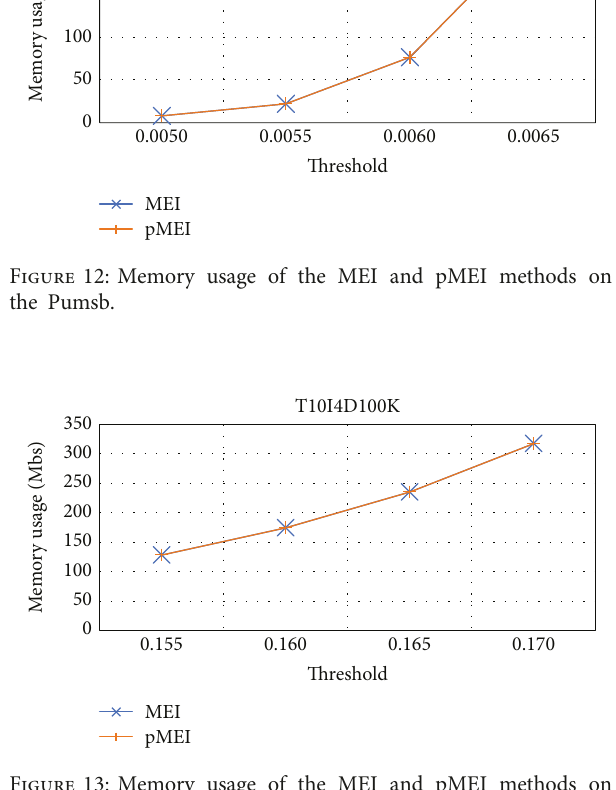
Figure 13: Memory usage of the MEI and pMEI methods on the